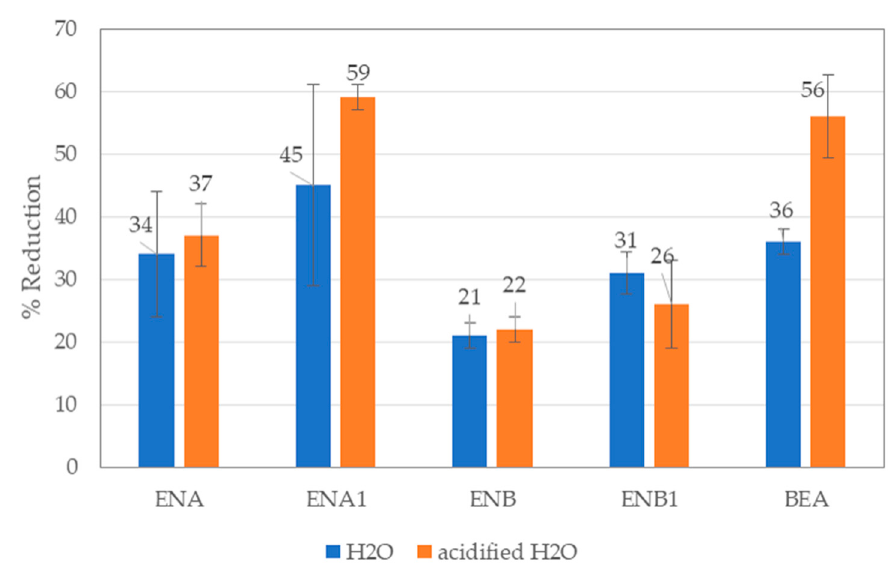
Figure 3. Percentage of reduction (%) of ENs and BEA in H 2 O vs. acidified H 2 O at pH = 4 after pulsed electric fields (PEF) treatment.